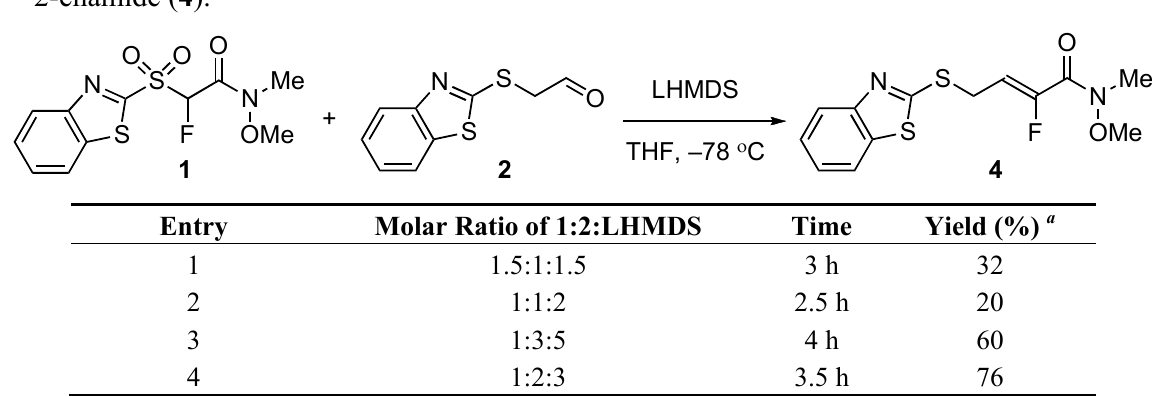
Table 2. Synthesis of ( Z )-4-(benzo[ d ]thiazol-2-ylthio)-2-fluoro- N -methoxy- N -methylbut- 2-enamide ( 4